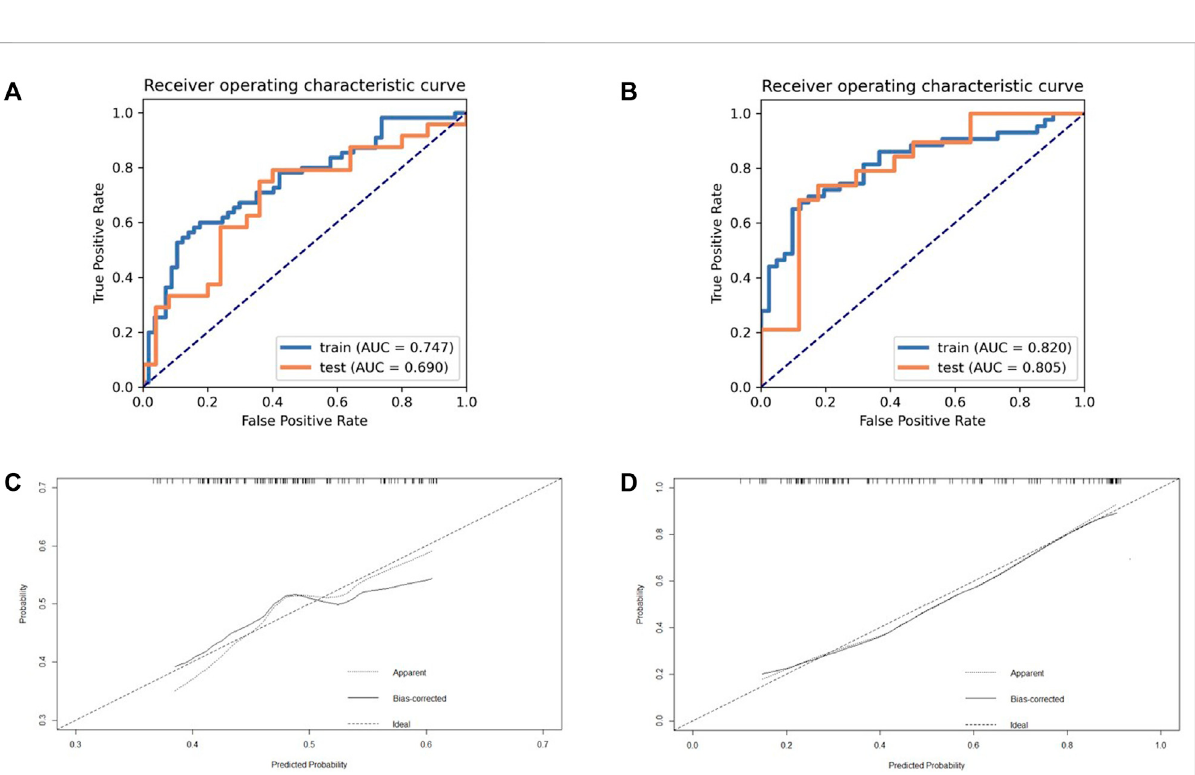
FIGURE 3 The ROC and calibration curve of R and R habitat . (a) The performance of training set and validation set on model R (based on whole tumor); (b) TheperformanceoftrainingsetandvalidationsetonmodelR habitat (basedondifferentmetabolicsub-regions). (c) Demonstratethecalibrationeffect of the R model; (d) Demonstrate the calibration effect of the R habitat